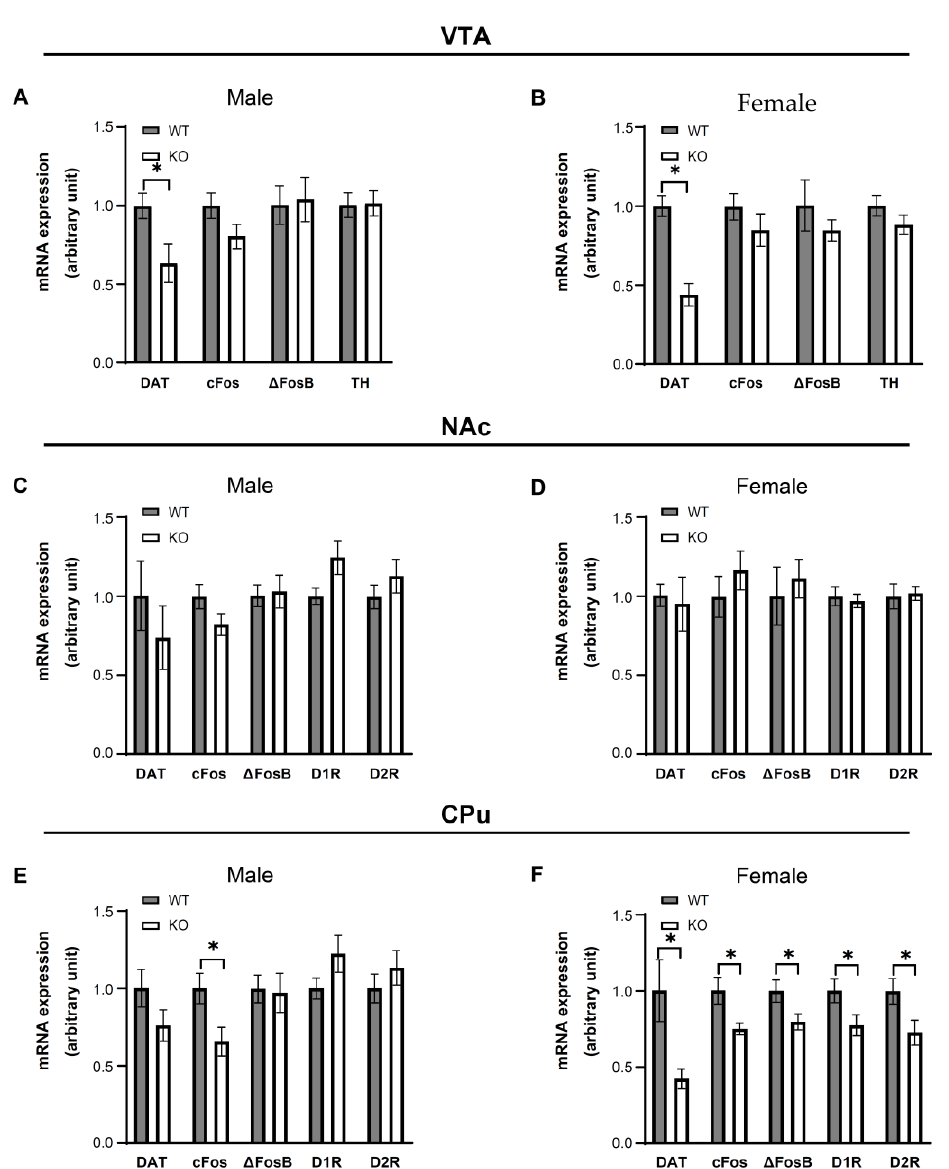
Figure 6. HFD feeding for 4 weeks alters dopamine-related gene expressions in mice. ( A – F ) Gene expressions were measured in the VTA ( A , B ), NAc ( C , D ), and CPu ( E , F ) of male ( A , C , E ) and female ( B , D , F ) WT and KO mice on HFD for 4 weeks. Data are mean ± SEM. Unpaired t test was used for statistical analysis of A to F. * p < 0.05, versus WT. The details of statistics are shown in Table S2.